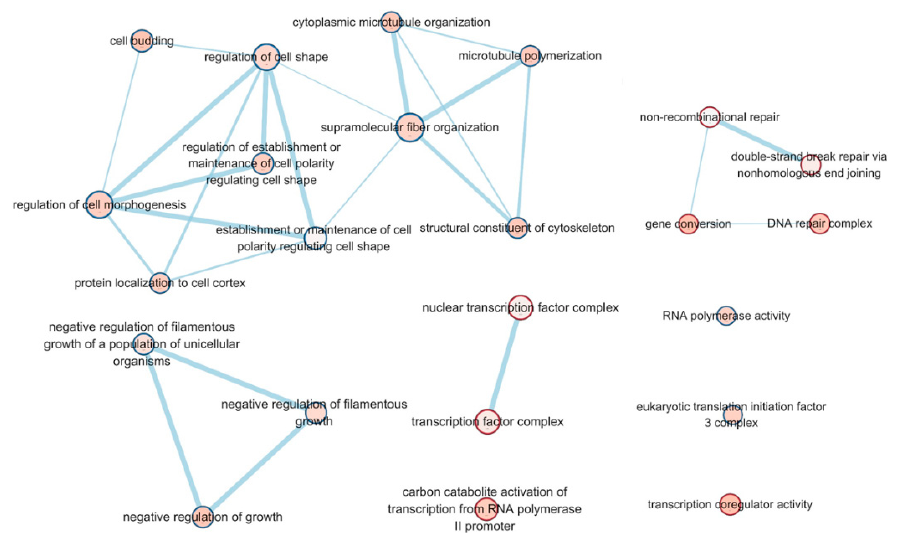
Figure 1. Gene set enrichment analysis (GSEA) of differentially expressed genes. Cytoscape and an enrichment map were used for visualization of the GSEA